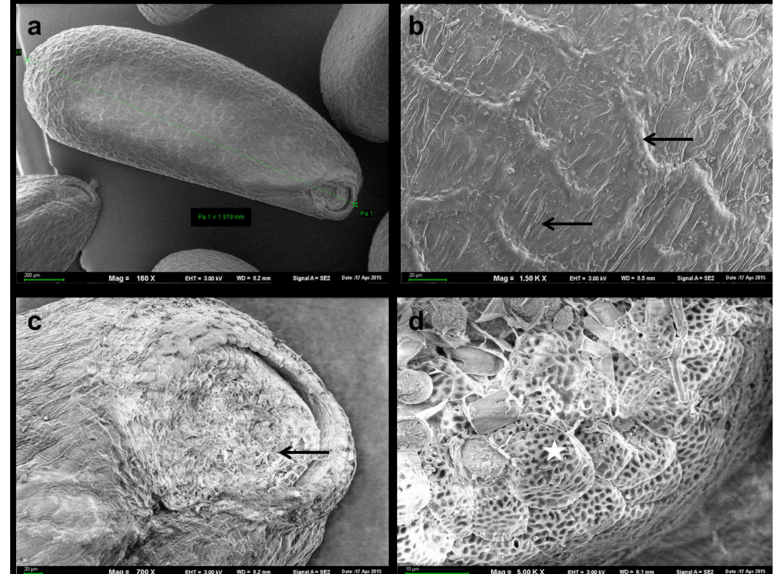
Fig. 1: Picture from scanning electron microscope (SEM). Morphology of lemon balm seed of the strain 7/2014. (A) The shape and size of seeds, 200 μm. (B) The characteristic sculpture of the seed coat texture (testa) with numerous cavities and convex (arrows), 20 μm. (C) The abscission tissue (cut-off) (star), 20 μm consisted of (D) sclerenchymatous cells (star), 10 μm.